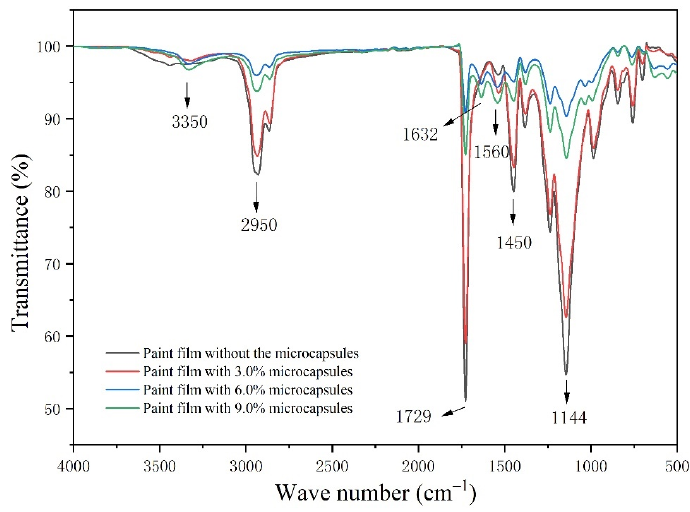
Figure 10. FTIR image of the paint films.